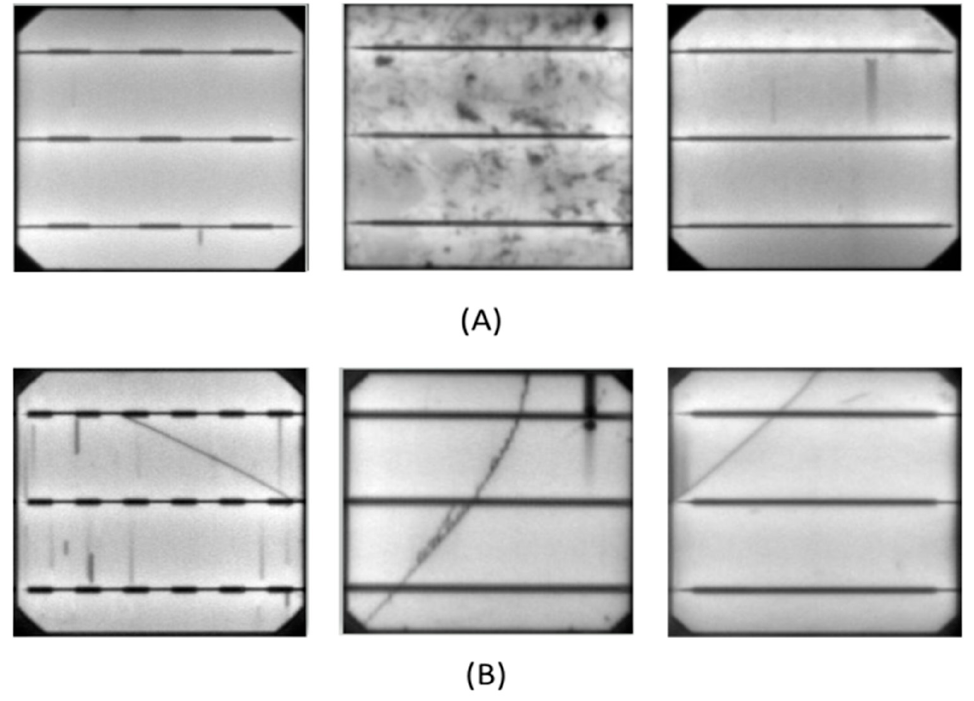
Figure 1. Data inspection ( A ) normal ( B ) Defective.